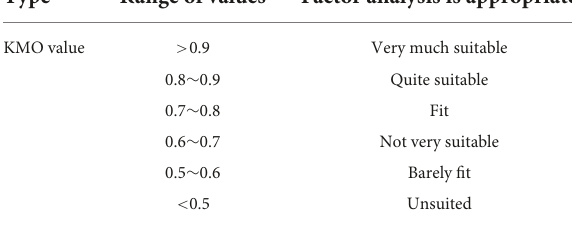
FIGURE4 Questionnaire distribution process.